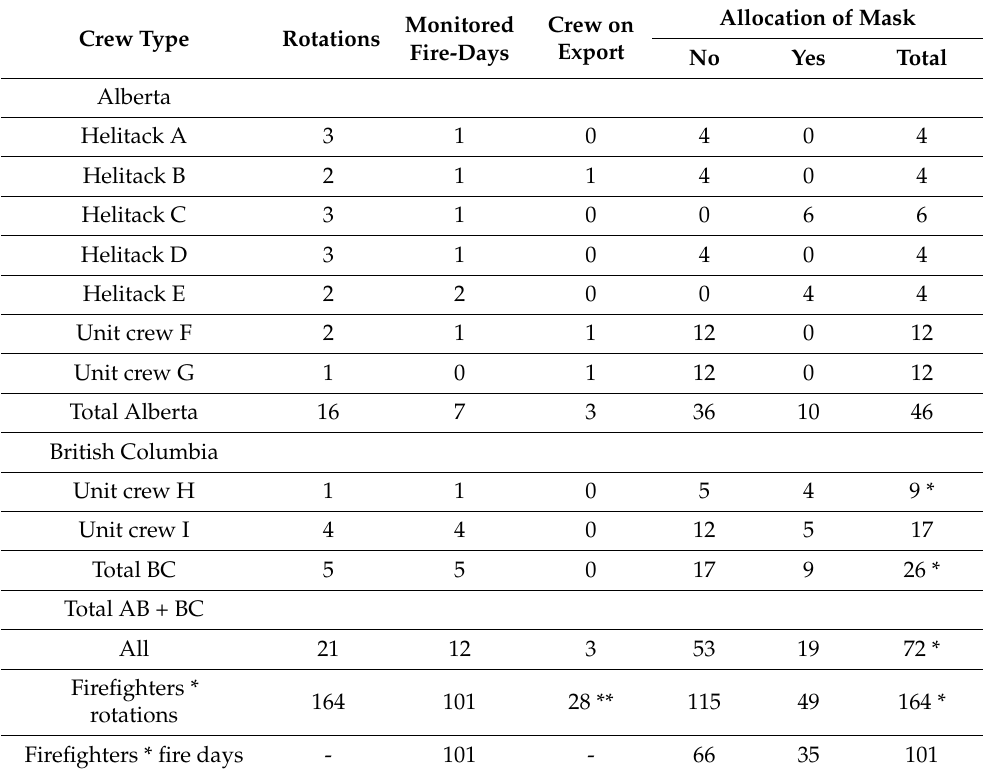
Table 1. Observations made in Alberta and BC during the 2021 fire